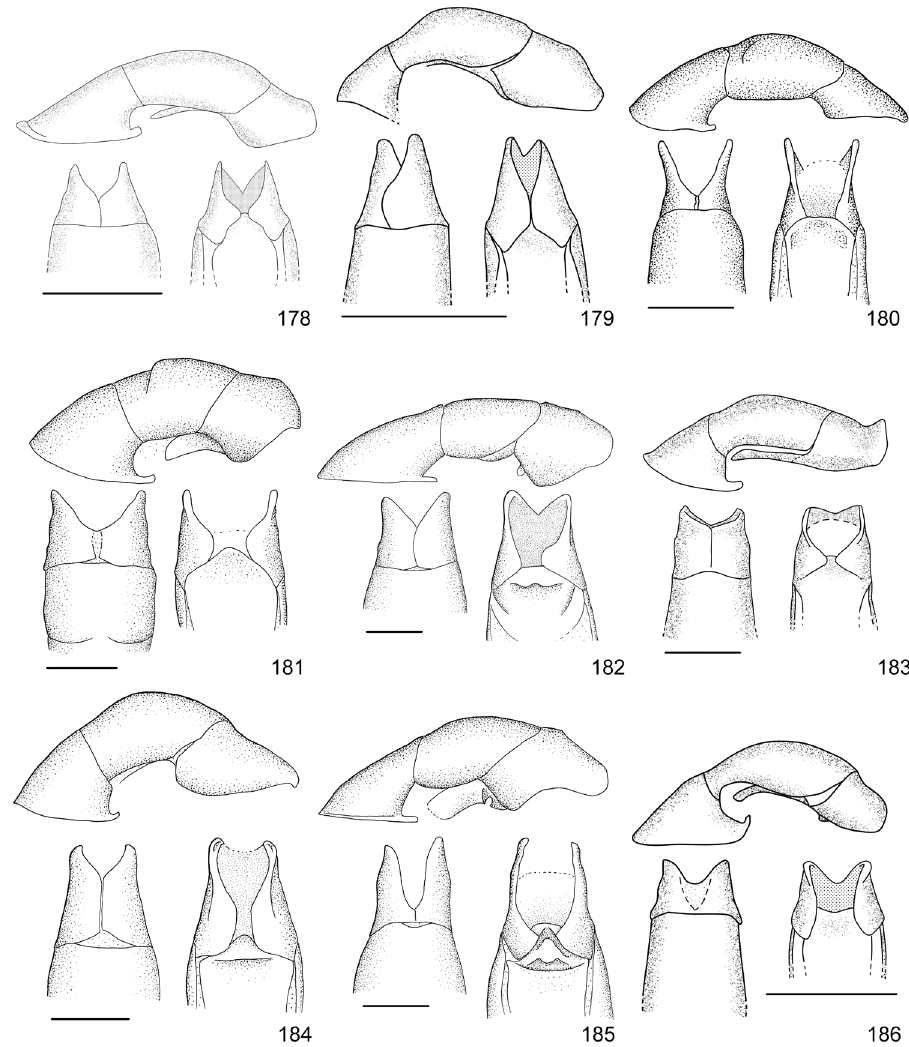
Figures 178–186. Shape of aedeagus, lateral view (top), dorsal view (bottom left), ventral view (bot- tom right). 178 Anomala strigodermoides (Bijagua, Alajuela, MNCR) 179 A. subaenea (Estación Maritza, Guanacaste, MNCR) 180 A. subridens (Reserva Forestal Río Macho, Cartago, MNCR) 181 A. subusta (Estación Cacao, Guanacaste, MNCR) 182 A. tenoriensis (Parque Nacional Volcán Tenorio, Alajuela, MNCR) 183 A. testaceipennis (Boca Tapada, Alajuela, MNCR) 184 A. trapezifera (Parque Nacional Tapantí, Cartago, CEUA) 185 A. tuberculata (Isla Bonita, Alajuela, CEUA) 186 A. undulata (Estación Cacao, Guanacaste, MNCR). Scale bars: 1 mm. Fig. 183 modified from Filippini et al. (2014); Fig. 178 from Filippini et al. (2015c); Figs 180–182, 184–185 from Filippini et al.